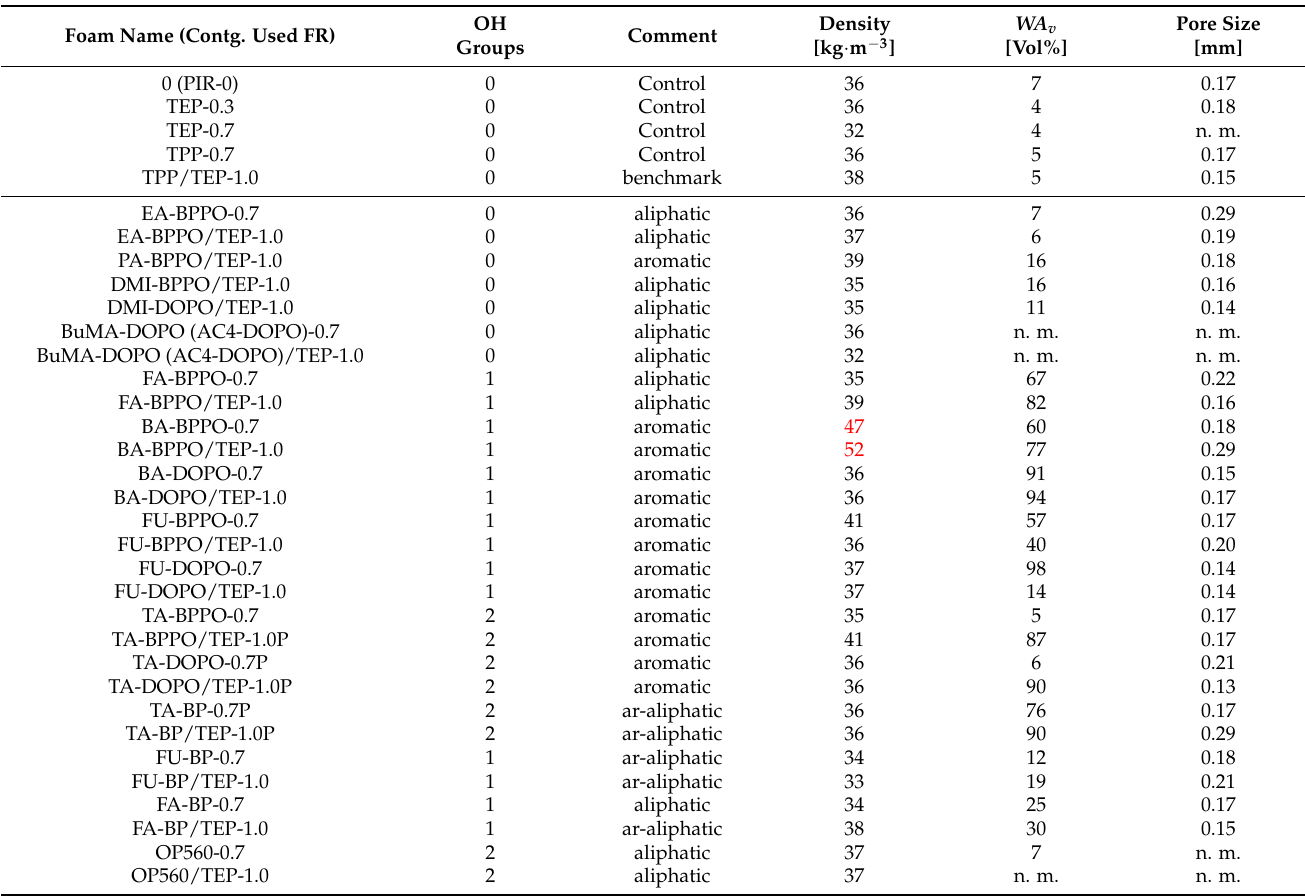
Table 3. Characteristic physical properties of the PIR foams with nonreactive and reactive FRs (red: foams with densities outside the target